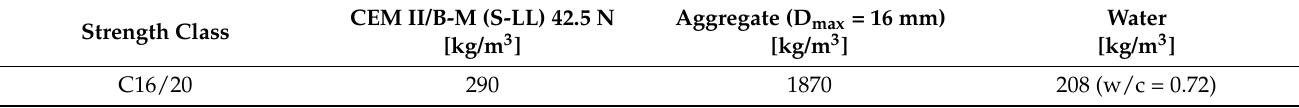
Table 2. Concrete mix